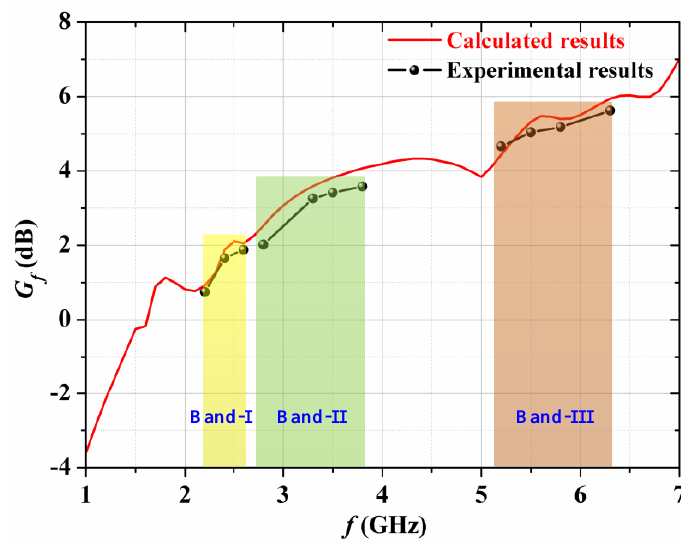
Figure 14. Calculated and experimental Gain of the proposed NTTPA.